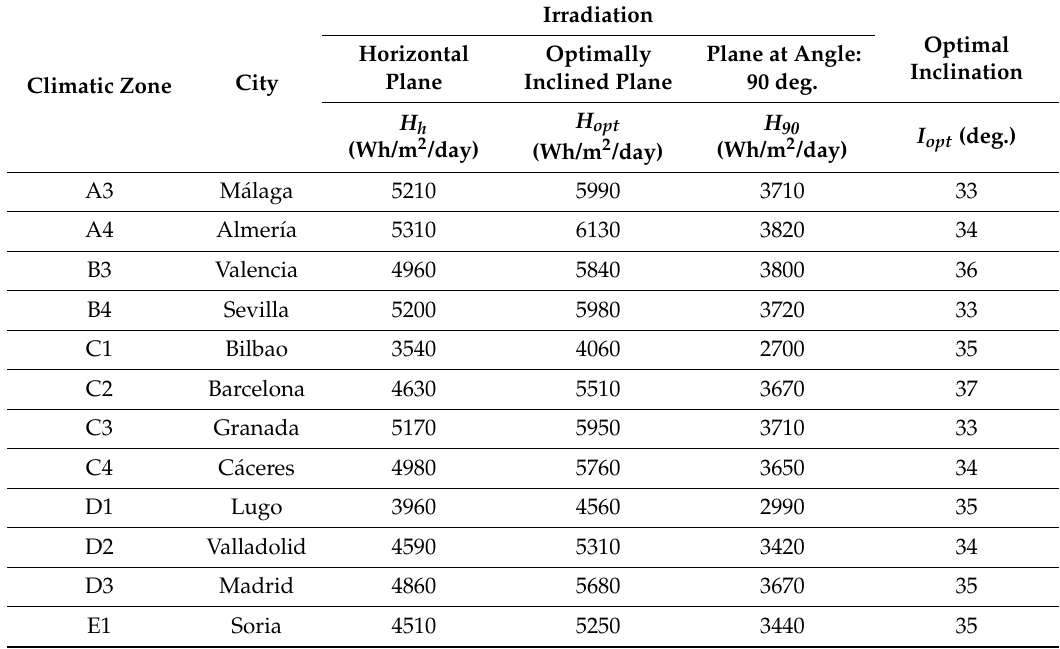
Table 4. Global irradiation